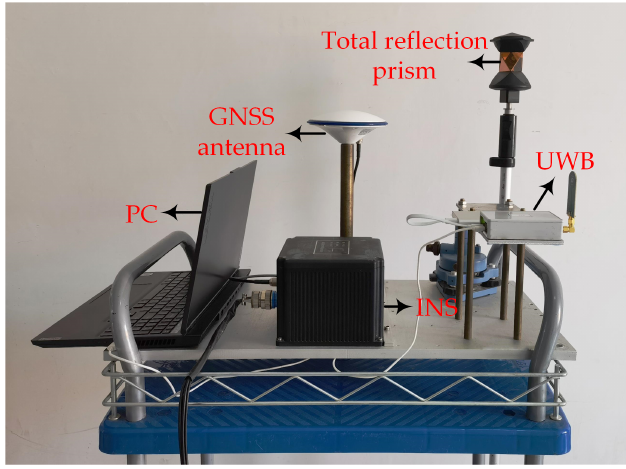
Figure 5. Experimental platform and sensor layout. Table 5. Specifications of the